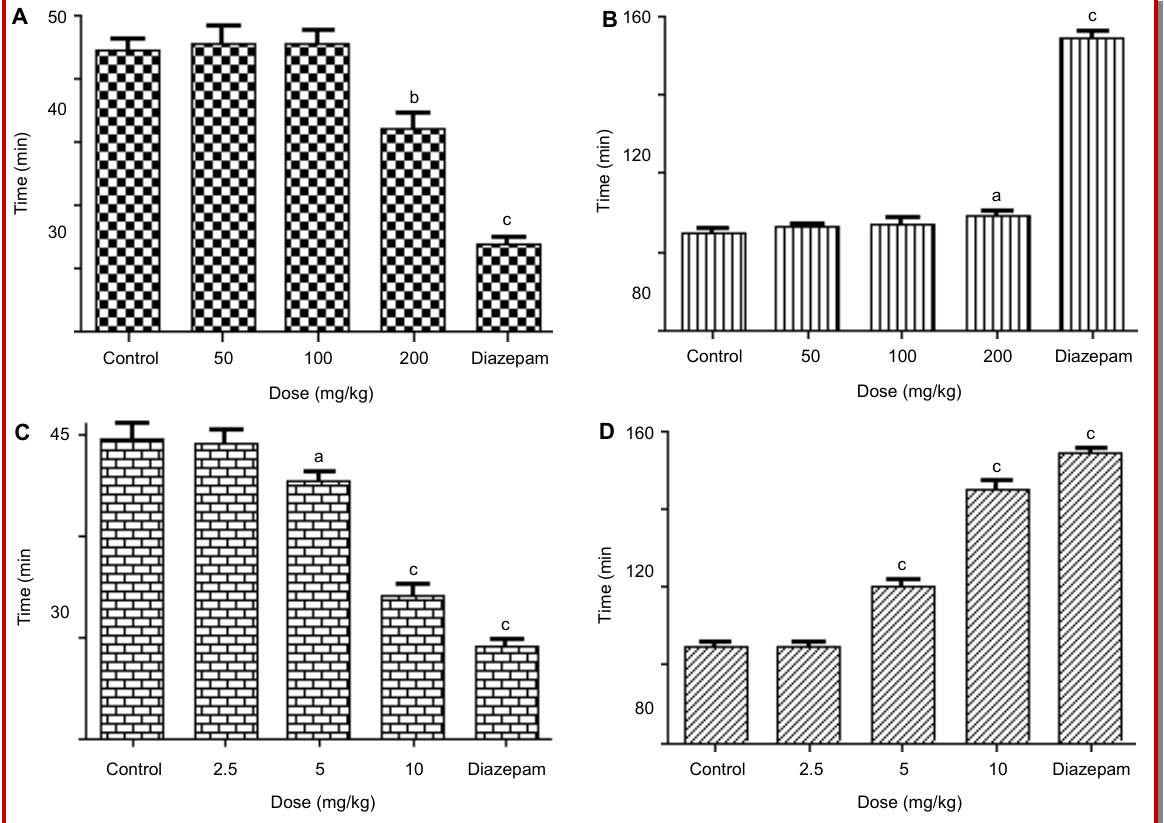
Figure 4: Effect of crude extract and n -hexane fraction of C. annuum at test doses in thiopental induced sleep in mice. onset time of sleep (A), duration of sleep (B) for crude extract and onset time of sleep (C), duration of sleep (D) for n-hexane fraction. Con- trol (Saline and tween 80 2.5%), 50,100,200 mg/kg (crude extract of C. annuum ), 2.5,5,10 mg/kg ( n -hexane fraction of C. annuum ), and Diazepam 1 mg. All values are expressed as mean ± SEM, n=6., a p<0.05, b p<0.01, c